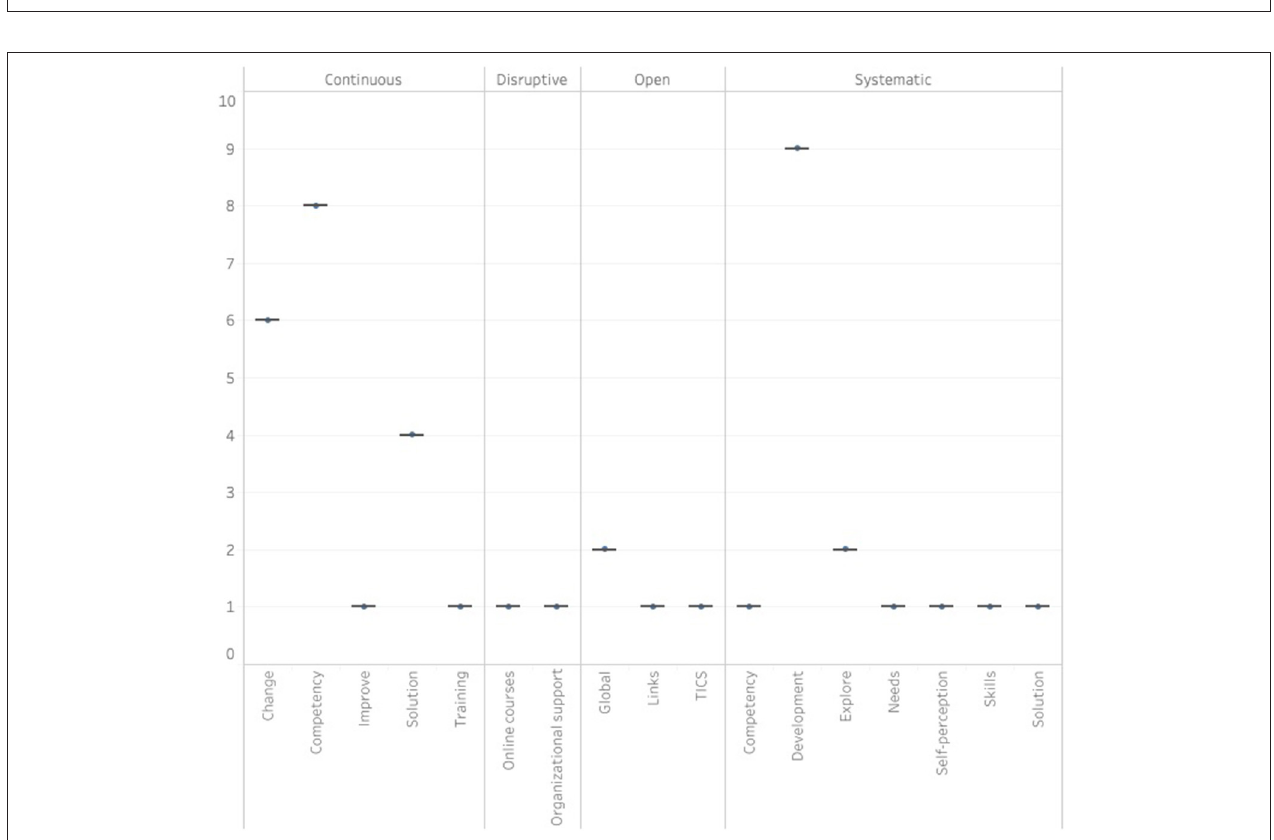
FIGURE 5 | Types of innovations related to the development of academic reading and